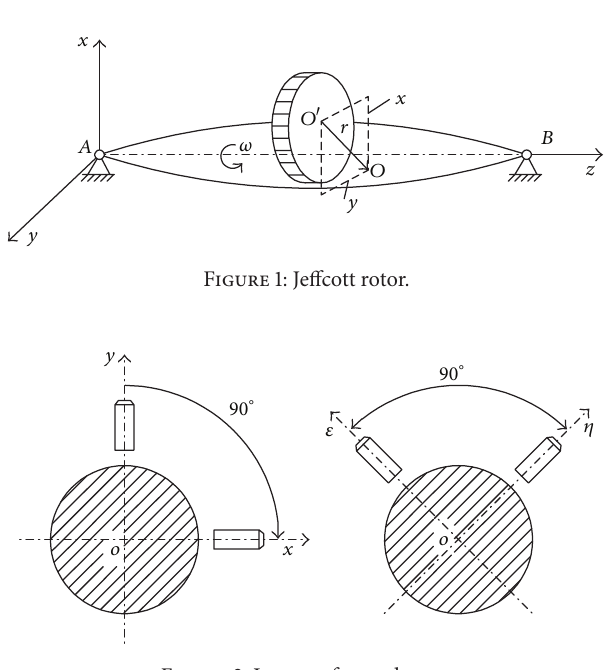
Figure 2: Layout of